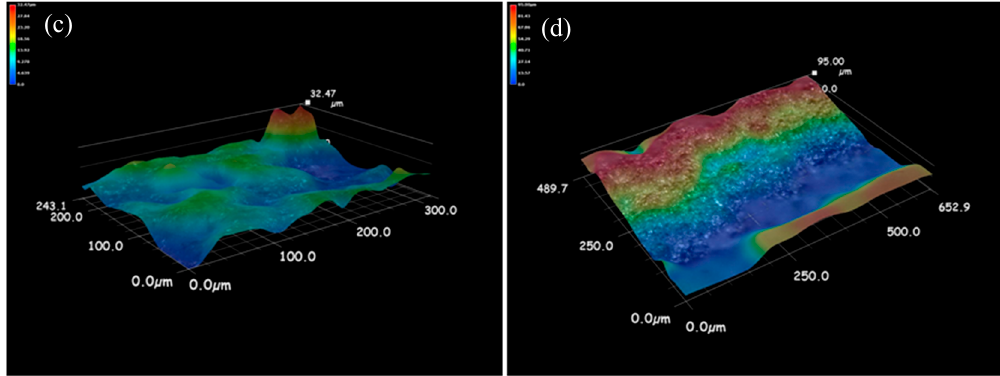
Figure 9. 3D morphology of impact fracture surface with different CeO 2 content: ( a ) 0.0% CeO 2 , ( b )